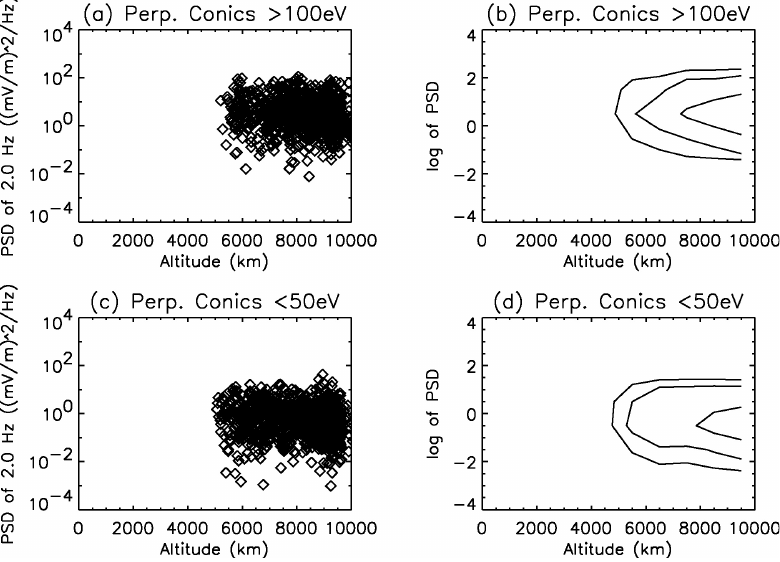
Fig. 6. Power spectral density at 2.0Hz associated with perp. conics as a function of altitude. Upper and lower panels show those associated with high- and low-energy ion conics,